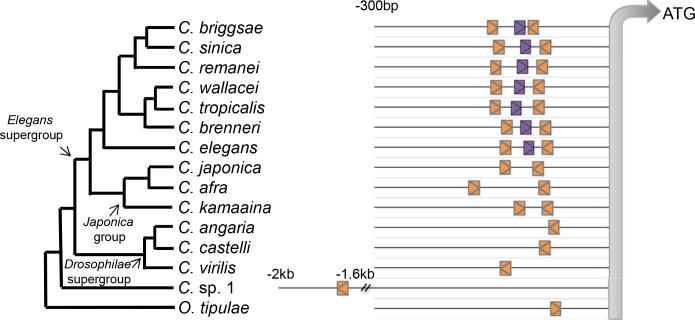
Evolution in the cis-regulatory elements necessary for lin-3 expression in C. elegans.Distribution of cis-regulatory elements (the regulatory triplet) in different species. 300 bp upstream of the ATG of the vulval isoform of lin-3 are shown (and up to 2 kb for C. sp. 1, where no upstream ATG is found). Orange depicts the E-box and purple the NHR site. “>” or “<” show orientation of the regulatory site.